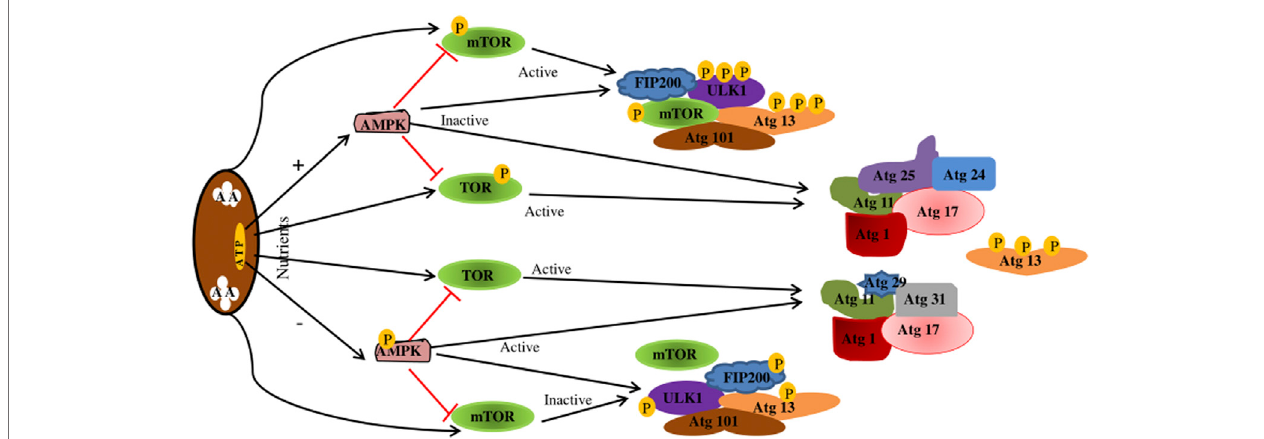
FIGURE 3 | Regulation of the Atg1/ULK1 complex. When nutrition is suf fi cient, AMPK is inactivated, TOR is activated, Atg13 is phosphorylated, the kinase activity ofAtg1complexisreduced,andautophagyisinhibited.mTORbindstoULK1SER757,inhibitingULK1-AMPKinteractions,resultinginULK1inactivationandautophagy shutdown.Instarvationstate,AMPKisactivated,TORisinactivated,Atg13isdephosphorylated,andtheAtg1complexiscompletedtoinitiateautophagy.WhenAMPK is activated, mTOR is inactivated. Activated AMPK catalyzes ULK1 phosphorylation at Ser317, Ser467, Ser555, and Ser574, thereby promoting autophagy. AMPK, adenosine monophosphate-activated protein kinase; TOR.